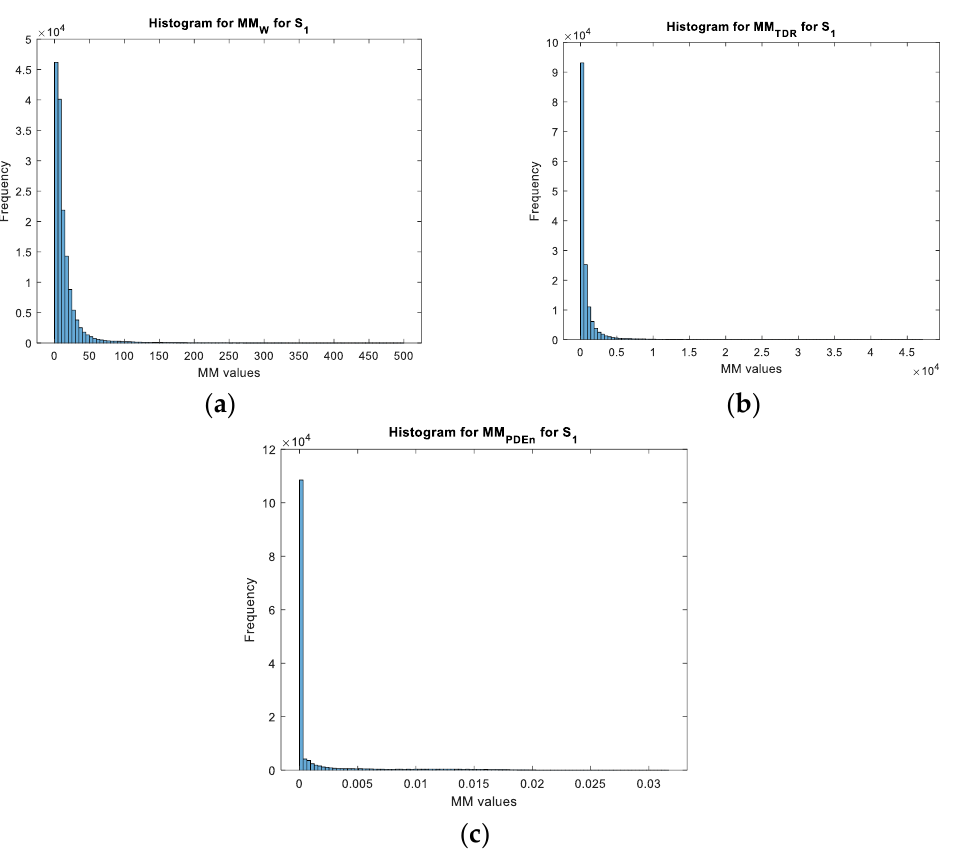
Figure 12. The histogram for the movement maps from S1 for the human target: ( a ) The wavelet transform approach; ( b ) the TDR approach; and ( c ) the PDEn approach.